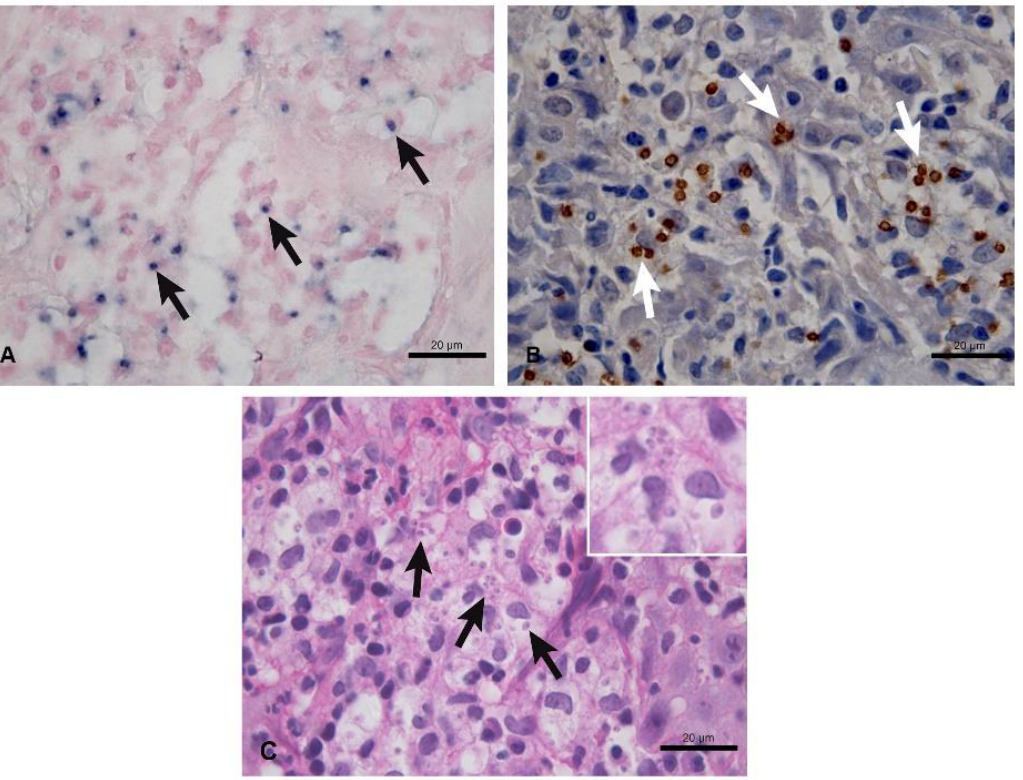
Figure 1. Positive staining for amastigotes in samples fixed in 10% formalin and paraffin-embedded of cutaneous lesions from patients with new world cutaneous leishmaniasis caused by L. ( V. ) braziliensis . ( A ) Dark-blue-stained amastigote forms (arrows) inside macrophages. Colorimetric in situ hybridization, 100 × objective. ( B ) Brown-stained amastigote forms (arrows) inside macrophages. Immunohistochemistry, 100 × objective. ( C ) Amastigote forms inside the parasitophorous vacuoles of macrophages (arrows and inset) in the dermis amidst an inflammatory reaction consisting mainly of macrophages, with fewer lymphocytes and plasma cells and rare neutrophils. Histopathology, 100 × objective.